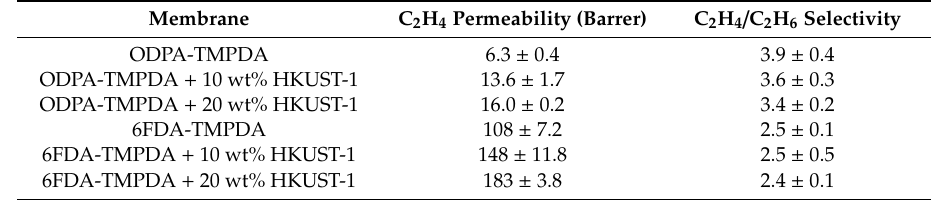
Table 1. C 2 H 4 / C 2 H 6 permeation behavior of pure ODPA-TMPDA and 6FDA-TMPDA membranes together with nanocrystal HKUST-1-containing mixed-matrix membranes. a